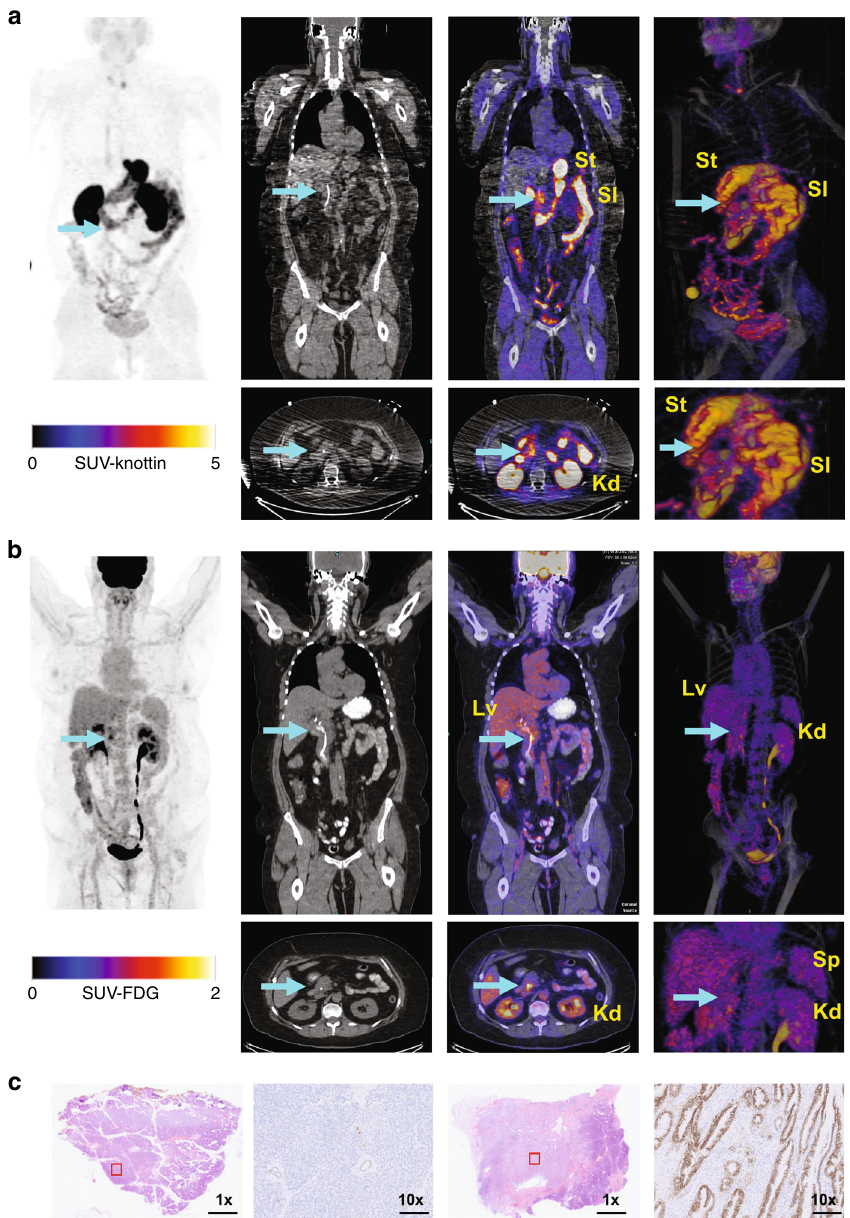
Fig. 3 [ 18 F]FP-R 0 1-MG-F2 PET imaging of pancreatic cancer. a [ 18 F]FP- R 0 1-MG-F2 and ( b ) [ 18 F]FDG images, from left to right, show MIP, CT, PET/CT (axial and coronal) and volume rendered PET/CT (full and magni fi ed) images of a 71-year-old female pancreatic cancer patient at ~60 min post injection. The liver, kidneys, small intestines, stomach and spleen are denoted by Lv, Kd, SI, St, and Sp, respectively. The cyan arrow points to the tumor. a Accumulation of [ 18 F]FP- R 0 1-MG-F2 at the head of the tumor is shown by the cyan arrow (SUV mean = 6.3). PET/CT images demonstrate several regions of relatively high accumulation including the kidneys, the main clearance route, and the stomach (St), small intestines (SI) where integrin α v β 6 is expressed. b An area of focal [ 18 F]FDG uptake (SUV mean = 2.3) which is located within the tumor coincides with a biliary stent (white tube) that is apparent in the CT image. The tracer is seen draining out of the kidney (Kd) through the ureter and collecting in the bladder in the MIP, and volume rendered PET/CT images. c From left to right, H&E staining and IHC analysis of the resected pancreatic mass, which included some healthy pancreatic tissue. A section of normal pancreas (left) and a section of malignant tissue (right) are shown. Scale bars on the 1x and 10x images represent 2.5 cm and 250 mm,